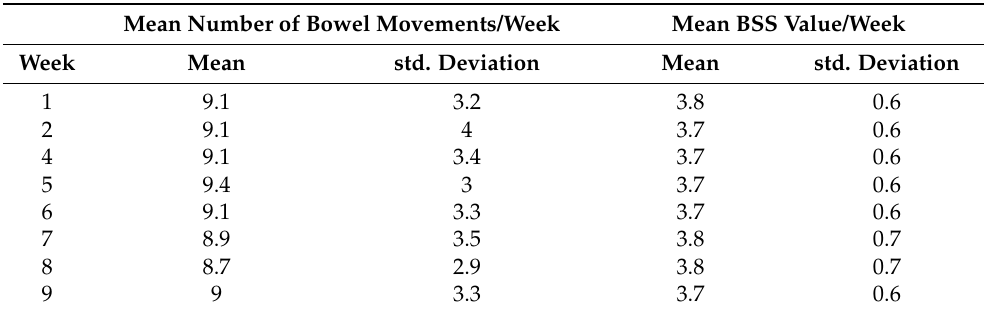
Table 1. Mean number of bowel movements and mean BSS values. No values for week 3 are available. Mean Number of Bowel Movements/Week Mean BSS Value/Week Week Mean std. Deviation Mean std.